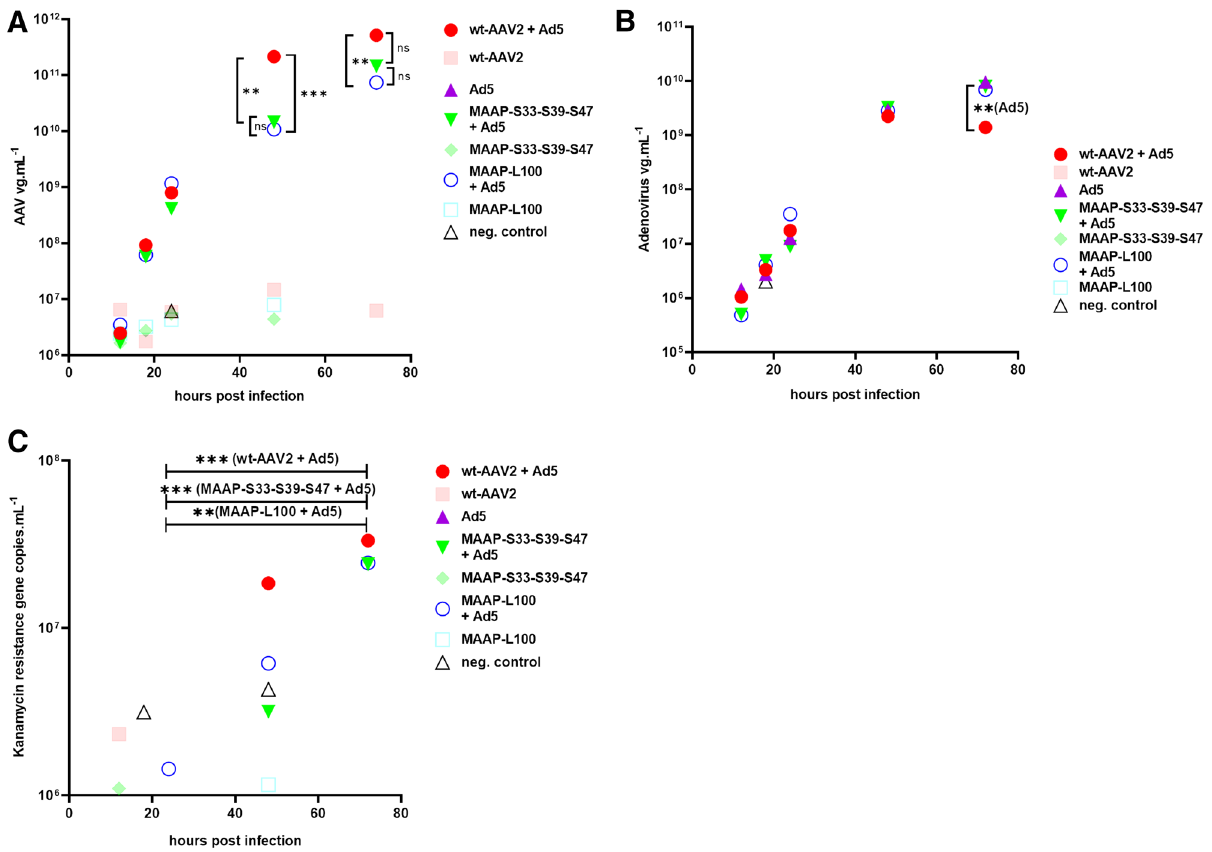
Figure 13. MAAP inactivation and its effect, in the context of AAV2 and Adenovirus 5 co-infection. We generated wt-AAV2, AAV2-MAAP-S33-S39-S47 and AAV2-MAAP-L100 viruses using plasmid transfection of 293 T cells. The harvested viruses were used to infect 293 T cells at an MOI of 500 with or without Adenovirus 5 added at an MOI of 50. Samples were harvest at 12, 18, 24, 48, 72 hpi and AAV vg titers ( A ), adenovirus vg titers ( B ), and kanamycin resistance gene titers ( C ) were quantified. Medians of the titers are represented. Statistical significance between samples was evaluated using Kruskal–Wallis test followed by Dunn’s multiple comparison